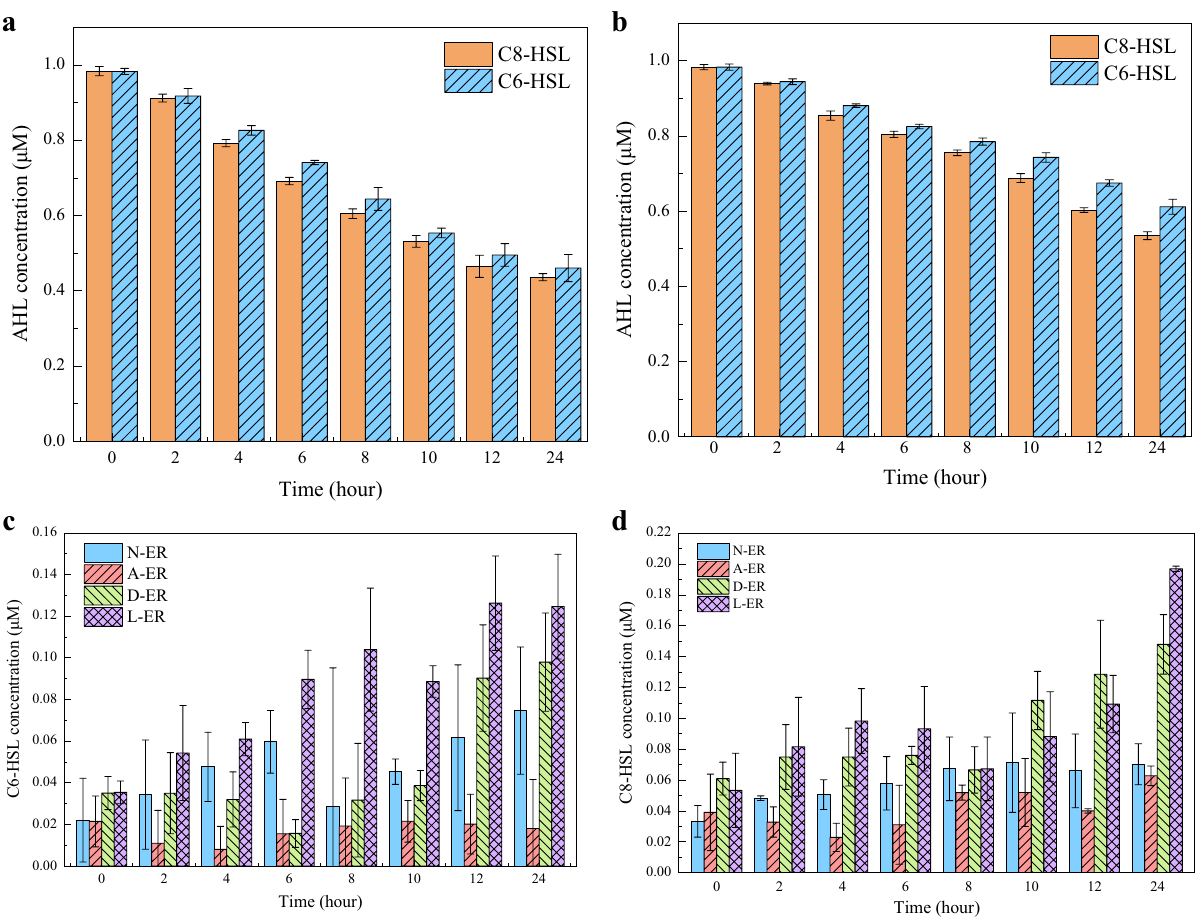
Figure 3. Detection of the degradation and usage of AHL in sludge supernatant sample in four groups reactors by UPLC-MS/MS. ( a ) The degradation of AHL in 24 h when pH = 8.0; ( b ) the degradation of AHL in 24 h when pH = 5.5; ( c ) the usage of C6-HSL in four AHL addition reactors; d: the usage of C8-HSL in four AHL addition reactors. N normal group, A acid group, D DCD group, L low temperature group, ER experiment reactor. Error bars are defined as standard error of the mean (n = 3, biological replicates).